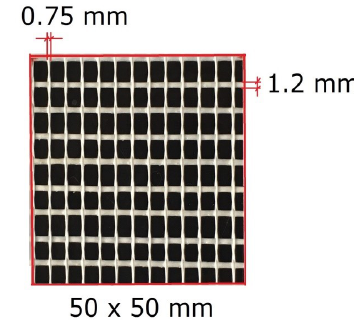
Figure 12: The total area of the gaps is equal to 1590 mm 2 (for 145 g/m 2 the fibreglass